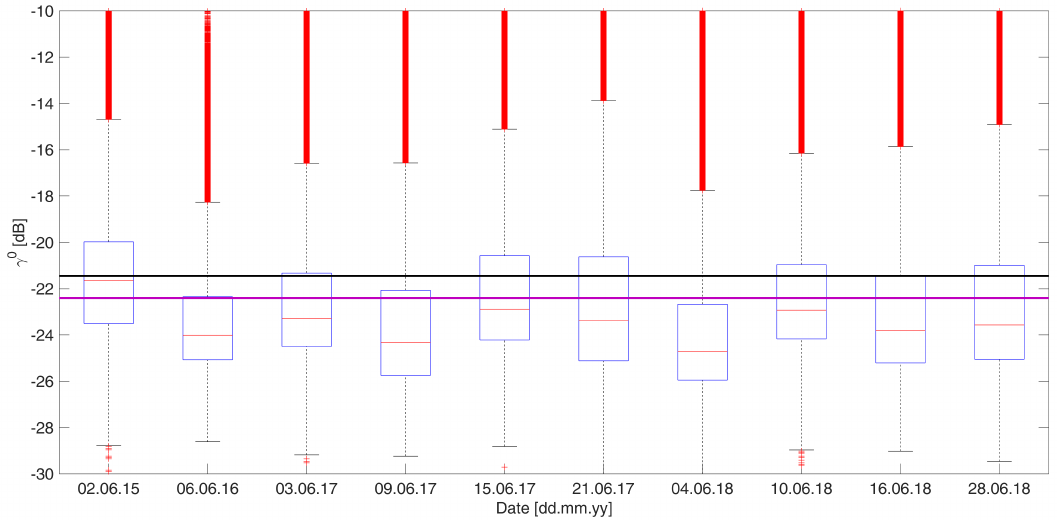
Figure 3. Box plots of backscatter distributions of all recorded cross-polarized June acquisitions in descending orbits with calculated coefficients of variation below 20% in Table 3. The red horizontal lines within the boxes represent the median in γ 0 , the boxes frame the interquartile range and the whiskers display extreme values not considered as outliers. Outliers are presented through red crosses. The black horizontal line displays threshold β 1 = 21.45 dB and the purple line displays threshold − − β 2 = 22.41 dB - for details see Section 2.2.4.